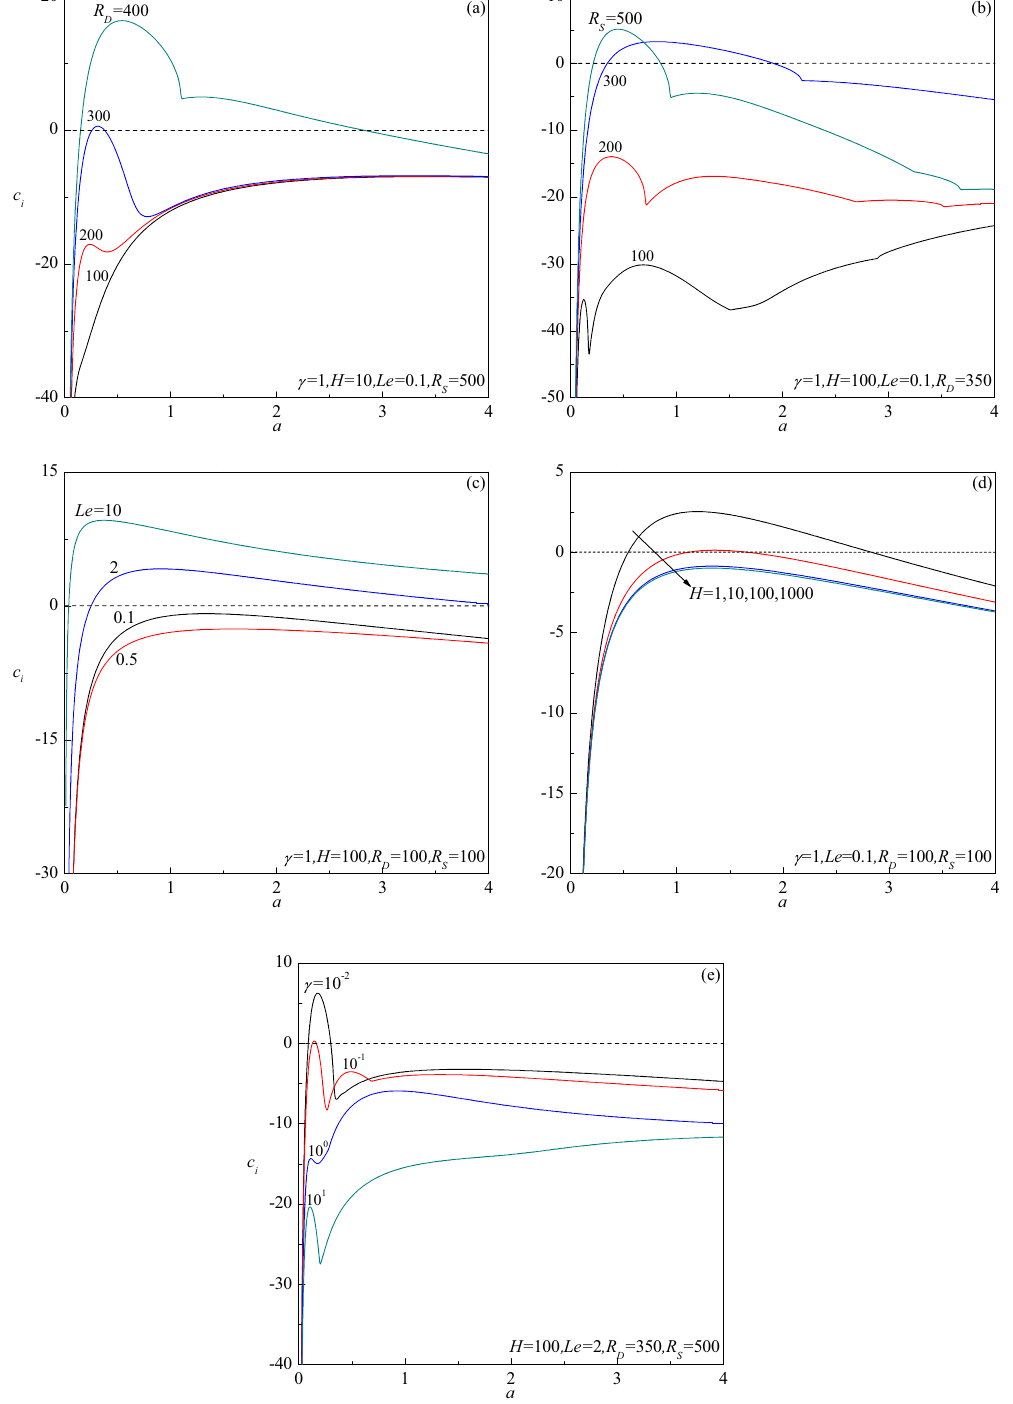
Figure 3. Growth rate c i versus a for different values of ( a ) R D , ( b ) R S , ( c ) Le , ( d ) H and ( e ) γ